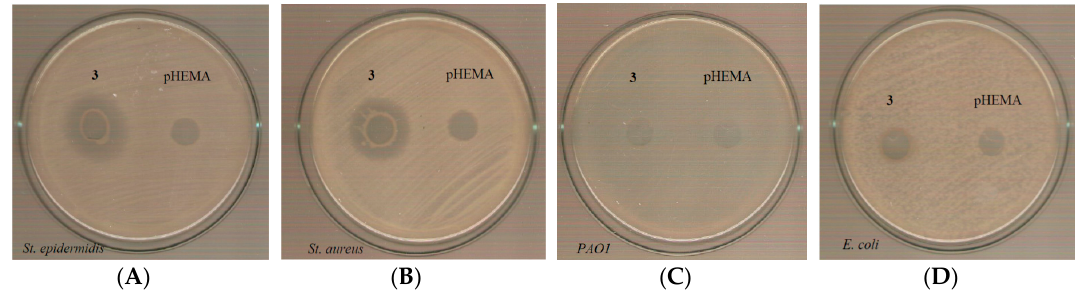
Figure 9. Inhibition zones of pHEMA and 3 against St epidermidis ( A ), St. aureus ( B ), PAO1 ( C ), and E. coli ( D ).